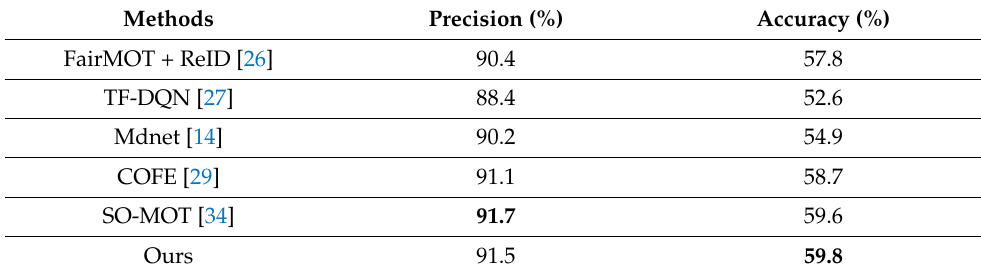
Table 2. Experimental results of target tracking algorithms for